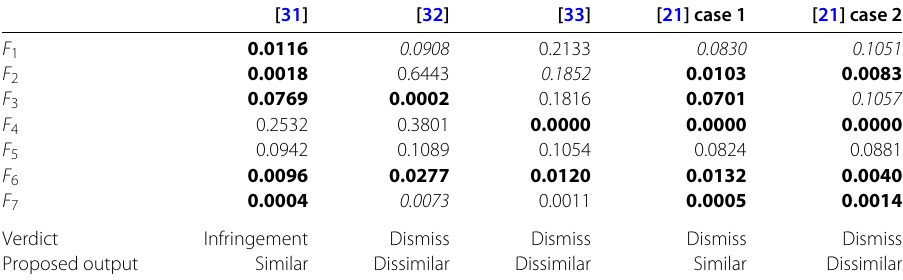
Italicized data indicate distance < 2 σ k ; boldface data indicates distance < σ